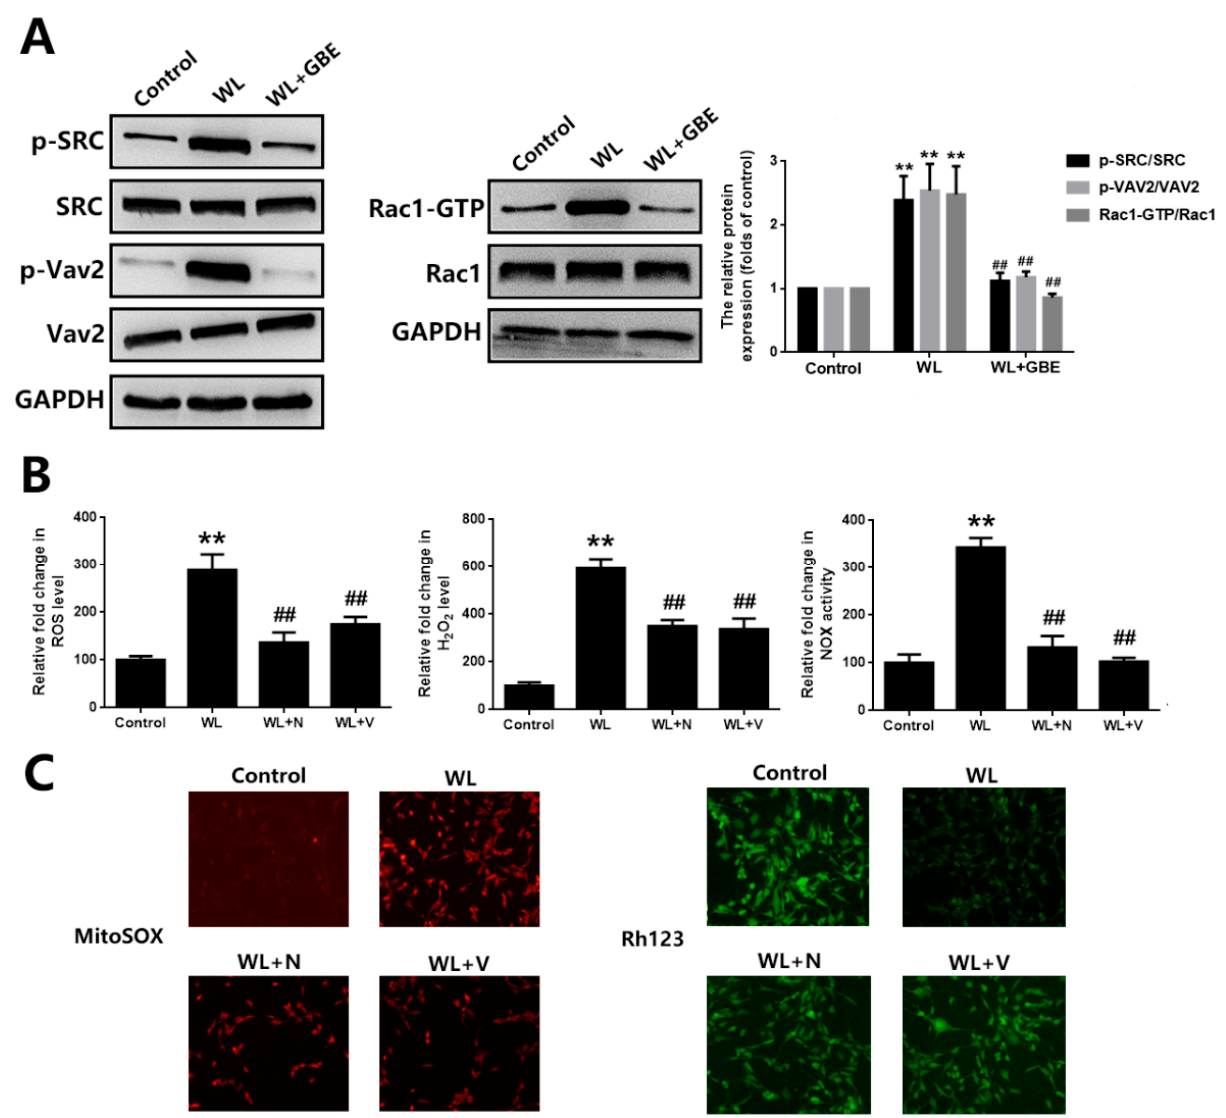
Figure 4. The influence of GBE treatment on redoxosome activation in 661W cells exposed to WL illumination. ( A ) Cells from the 661W cell line pre-treated with GBE (100 mg/L, 24 h) were exposed to WL (4000 lux) for 1 h. The expressions of redoxosome-related proteins were evaluated by Western blot analysis (left and middle panel). The densitometry analysis of protein expression is shown in the right panel. ( B ) The 661W cells pre-treated with Rac1 inhibitor (NSC23766, 80 µ M, 6 h) or NOX inhibitor (VAS2870, 10 µ M, 6 h) were exposed to WL (4000 lux) for 30 min. The level of intracellular ROS was assessed by DCFH-DA staining (left panel) and that of intracellular H 2 O 2 was studied using titanium sulfate colorimetry (middle panel). The activity of NOX was evaluated using DCPIP as an artificial electron acceptor (right panel). ( C ) The level of mitochondrial ROS was measured with mitoSOX staining (left panel). The level of MMP was assessed by rhodamine123 staining (right panel). ** p < 0.01 vs. Control, ## p < 0.01 vs. WL. WL: white light, DCFH-DA: 2,7-dichlorodihydrofluorescein diacetate, DCPIP: 2,6-dichlorophenol-indophenol, mitoSOX: mitochondrial superoxide indicator, Rh123: rhodamine123, N: NSC23766, V: VAS2870.